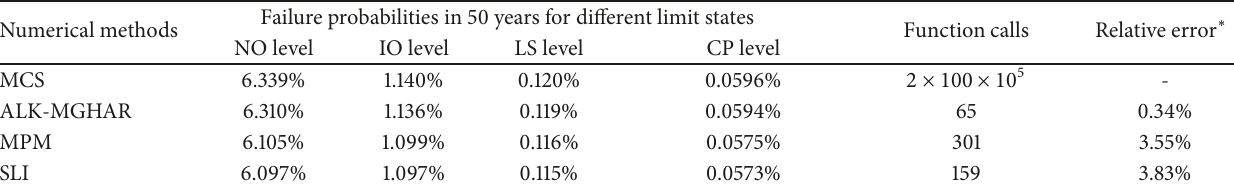
Table 4: Results with N 2 =2 by different methods.